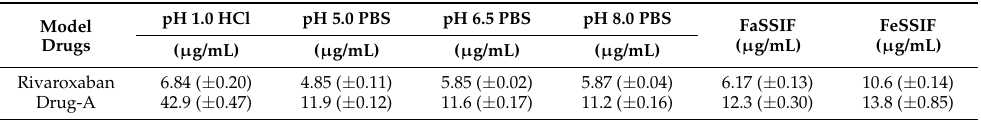
Table 2. The solubility of API in different media. ( n = 3).